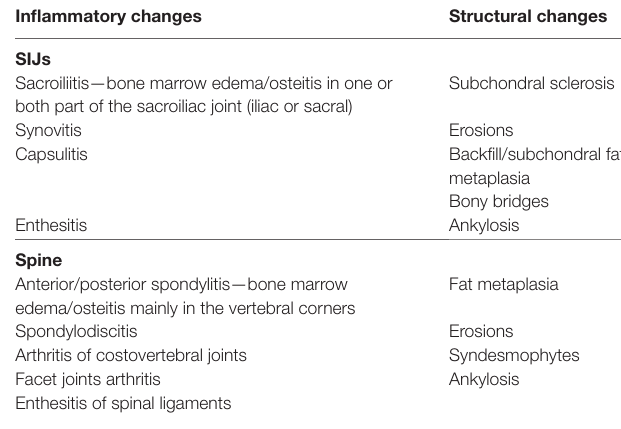
TAble 3 | Characteristic lesions in the sacroiliac joints and the spine of patients with axial spondyloarthritis as depicted by magnetic resonance imaging (37, 40). inflammatory changes Structural changes